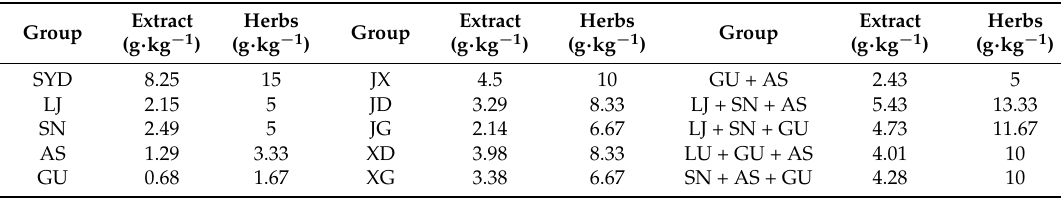
Table 4. The dose of different compatibility combinations for oral